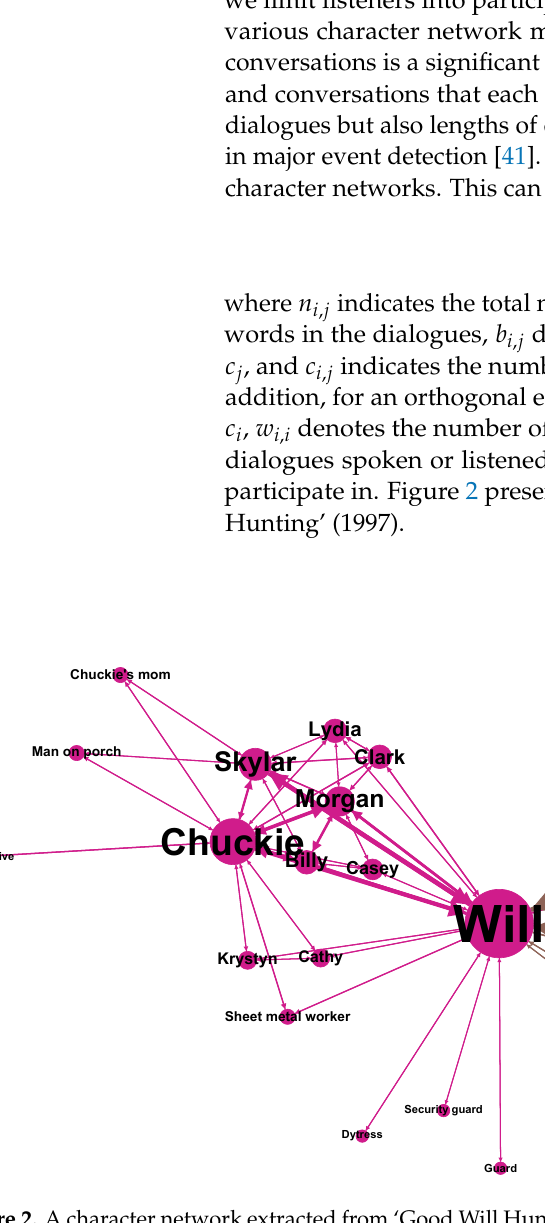
Figure 2. A character network extracted from ‘Good Will Hunting’ (1997). This figure is drawn by Gephi (https://gephi.org/ (accessed on 11 February 2021)) according to n i , j . The colors of nodes indicate their communities. Sizes of nodes are proportional to their out-degrees, and label sizes were adjusted according to node degrees. Lastly, the thickness of edges corresponds to proximity degrees between characters. To increase readability, we did not draw cyclic